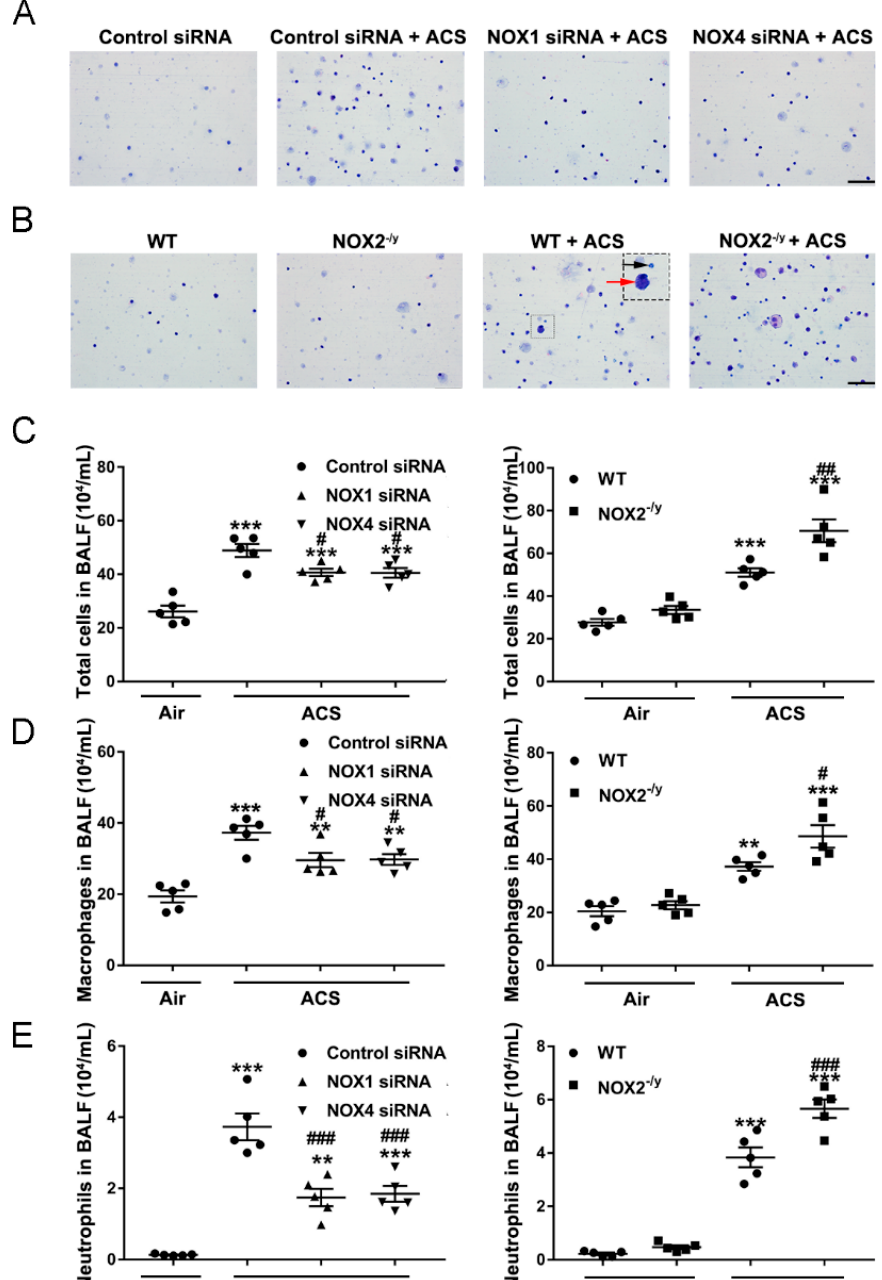
Figure 4. Knockdown of NOX1 or NOX4 in mice attenuated ACS induced inflammatory cell accumulation in BALF . Mice were exposed to CS or filtered air for 1 h, and BALF was collected at 6 h. Cells isolated from BALF were counted with a hemocytometer and stained with Giemsa. ( A ) Representative images of cells in BALF from ACS exposed mice transfected with control siRNA, NOX1 siRNA, or NOX4 siRNA. ( B ) Representative images of cells in BALF from ACS exposed WT mice and NOX2 − /y mice. ( C ) Total cell counts in BALF in ACS exposed mice silenced or knocked out of NOX1, NOX2, or NOX4 expression. ( D ) The number of macrophages (red arrowhead) in ACS exposed mice silenced or knocked out of NOX1, NOX2, or NOX4 expression. ( E ) The number of neutrophils (black arrowhead) in BALF in ACS exposed mice silenced or knocked out of NOX1, NOX2, or NOX4 expression. All data are presented as Mean ± SEM, n = 5. Scale bar, 50 µ m. ** p < 0.01, *** p < 0.001 vs. air exposed control group. # p < 0.05, ## p < 0.01, ### p < 0.001 vs. ACS exposed